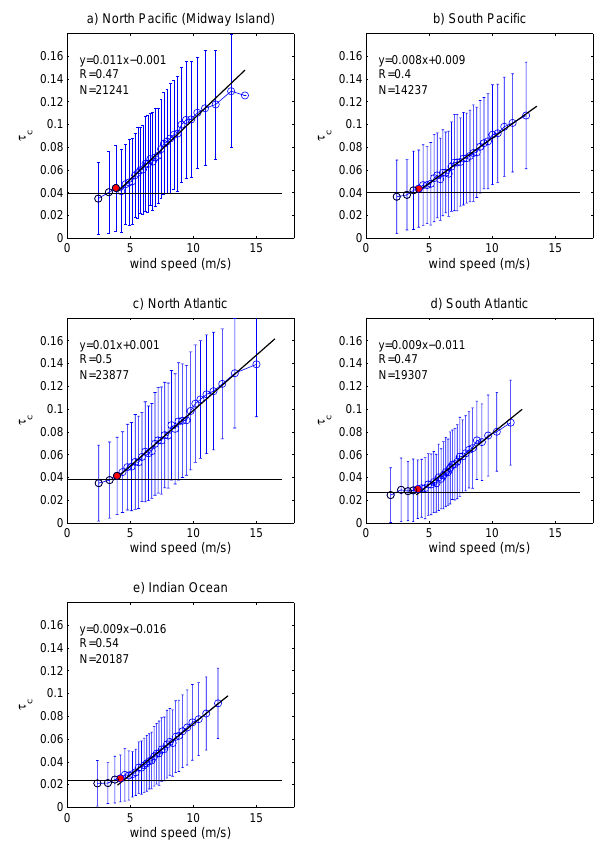
Fig. 3. MODIS-Aqua τ c plotted against AMSR-E W over the 5 ROIs (regions a–e in Fig. 1). The data were sorted according to W and divided into 30 bins of equal number of observations. Circles and error bars represent respectively the mean and standard devi- ation of τ c within each bin. The red data point and the horizon- tal line mark respectively the threshold wind speed above which τ c and W are linearly correlated, W 4 , and the value of the background aerosol, τ c 0 (see text). The regression equations and correlation co- efficients were calculated from the full cloud of data points before binning. The statistical analysis was performed on the daily data, without spatial and temporal averaging. The regression equations and correlation coefficients were calculated for data corresponding to W> 4m/s and are shown for τ c after subtracting the background